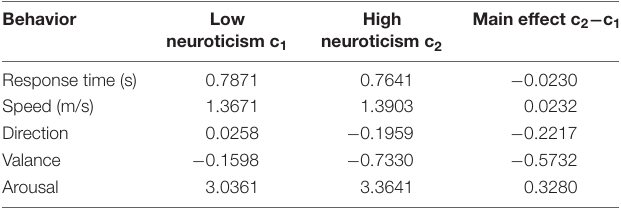
TABLE 3 | The main effect of neuroticism on escape behavior.